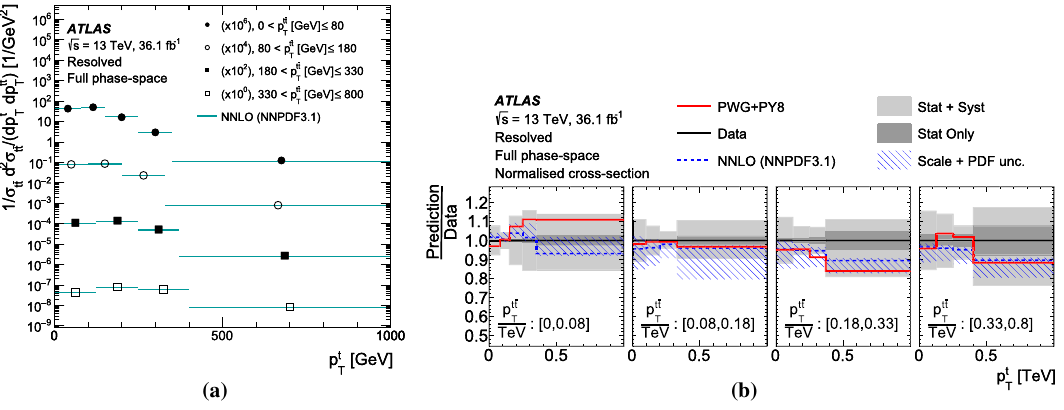
Fig. 59 a Parton-level normalised differential cross-section as a func- tion of p t in bins of p t ¯ t in the resolved topology compared with the T T NNLO prediction obtained using the NNPDF3.1 NNLO PDF set. Data points are placed at the centre of each bin. b The ratio of the measured